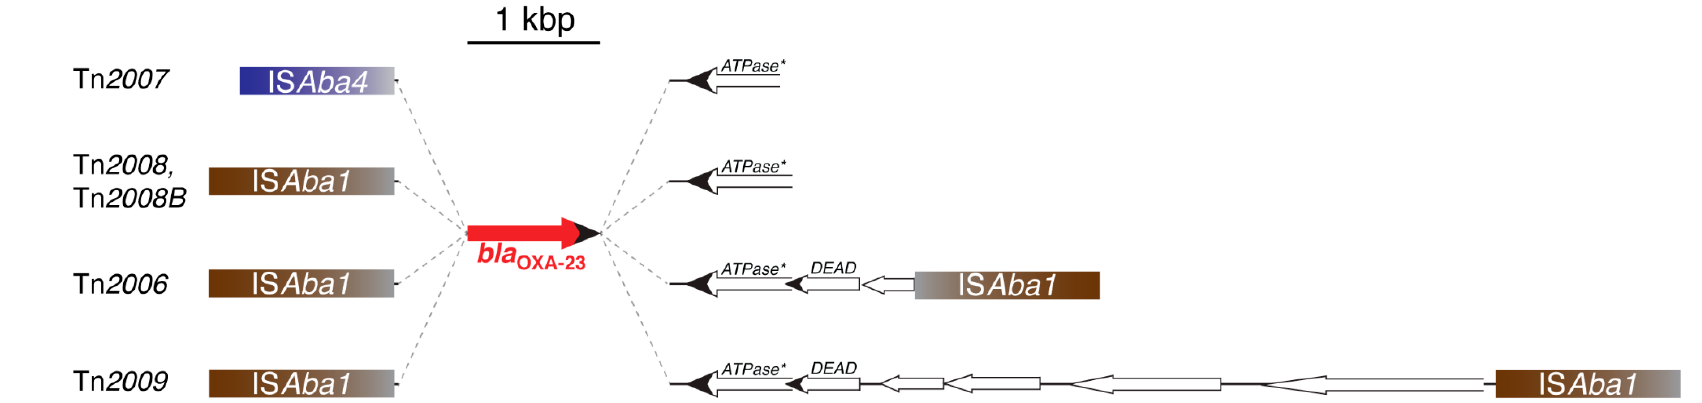
Figure 2. Genetic structures of bla OXA-23 -containing elements. The structure of Tn 2007 , which has not been proven to transpose, is shown on top. Tn 2008 and Tn 2008B differ in the number of nucleotides (27 and 34, respectively) that separate bla OXA-23 from IS Aba1 . Tn 2006 , the only structure experimentally shown to transpose [178], includes copies of IS Aba1 in opposite orientations, while Tn 2009 carries these insertion sequences in the same orientation. These two transposons are the only ones with the typical composite transposon structure. An extensive and detailed description of these elements was recently published [177]. ATPase*, gene coding for a putative ATPase truncated at the N-terminus. DADE, gene coding for a putative DEAD box family helicase [181]. Figure interpreted from Nigro and Hall (2016)